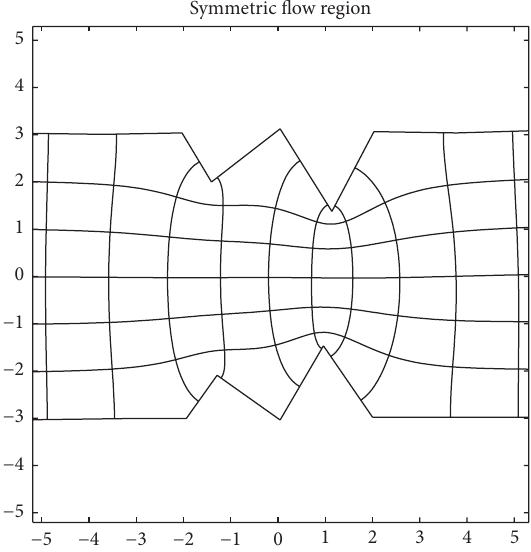
Figure 1: The symmetric domain in the complex 𝑧 -plane, where 𝑧 = 𝑥(𝜉, ̃𝜁) + 𝑖̃𝑦(𝜉, ̃𝜁) . The lower half ( 𝑥 ∈ [−5,5],𝑦 ∈ [−3,0] ) is ̃𝜁 = 0 the physical channel with 𝑦 = indicating the undisturbed free surface. Superimposed in this complex 𝑧 -plane domain are the (curvilinear) coordinate level curves from the 𝑤 -plane system 𝜉̃𝜁 . The polygonal line at the bottom of the figure is a schematic ̃𝜁 = ±√𝛽 ). This figure was representation of the topography (where generated using SC Toolbox